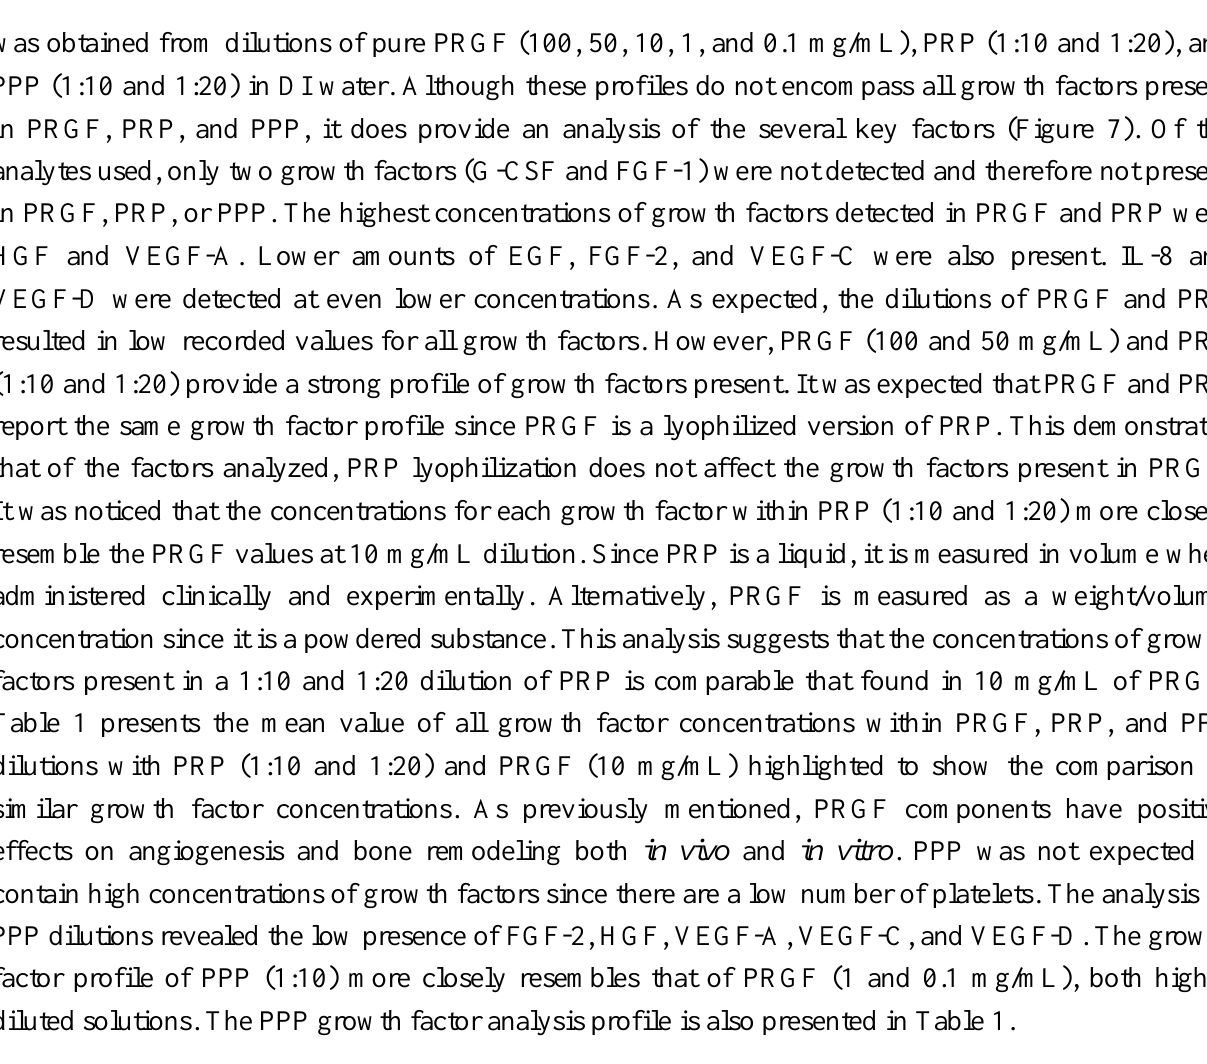
Table 1. Average growth factor concentration (pg/mL) in preparations rich in growth factors (PRGF), platelet-rich plasma (PRP), and platelet-poor plasma (PPP) dilutions. Detection). 6 mm PHC discs reported traces of epidermal growth factor (EGF). All